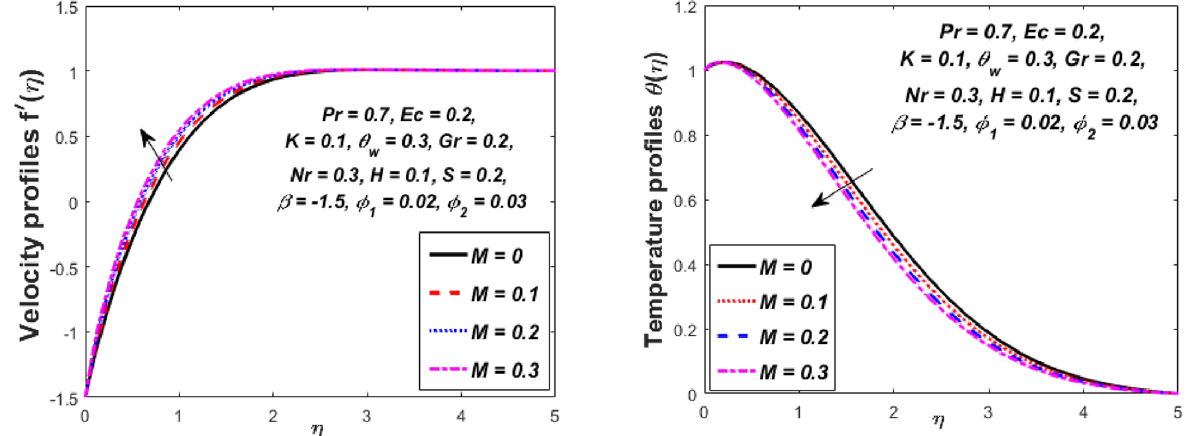
Figure 3. Influence of M on velocity f ′ (η) and temperature θ(η) profiles.